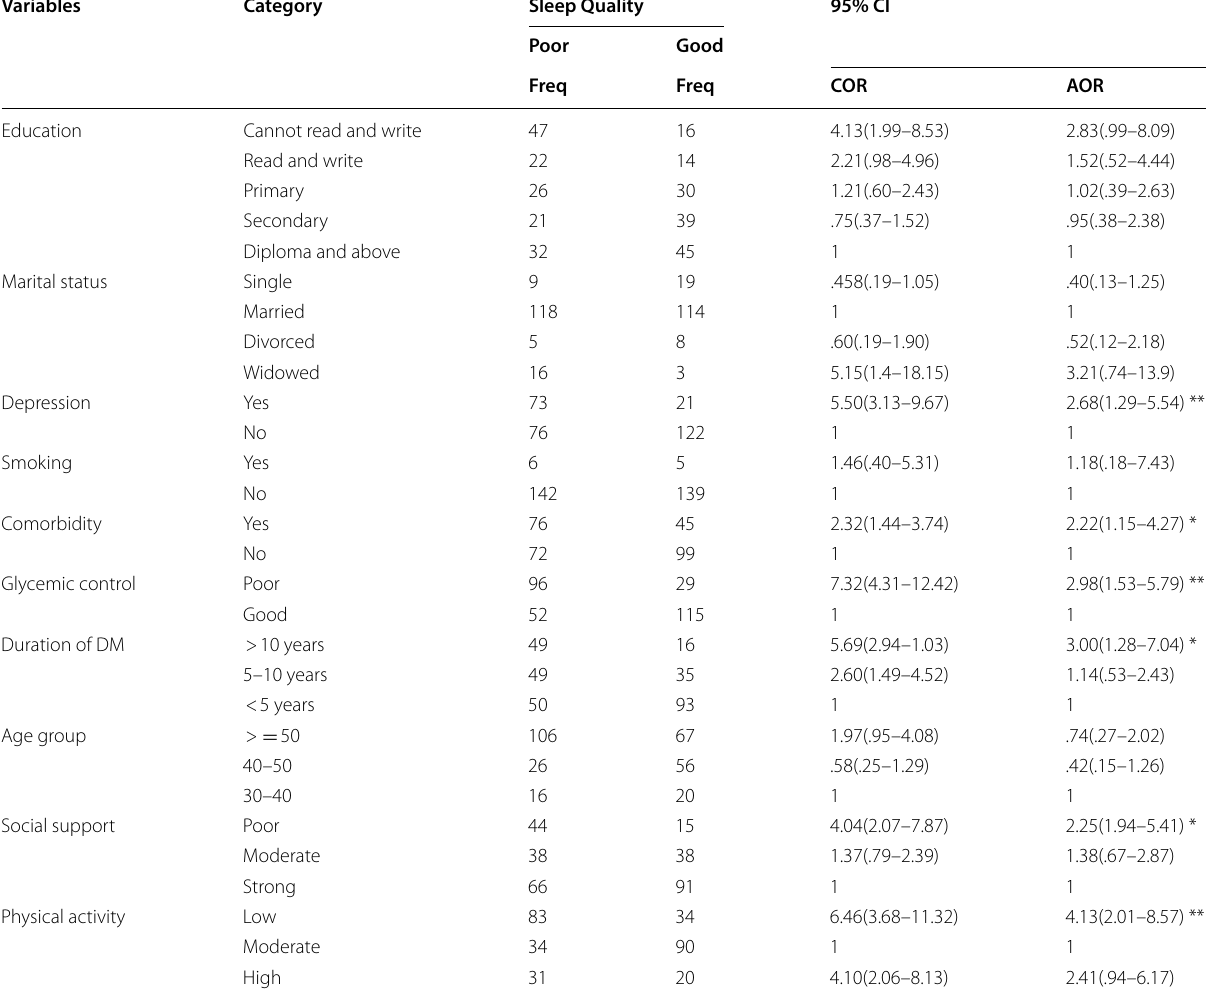
Table 8 Bi-variable and multivariable logistic regression analysis on sleep quality among individuals with type 2 DM Bahir dar, Ethiopia,